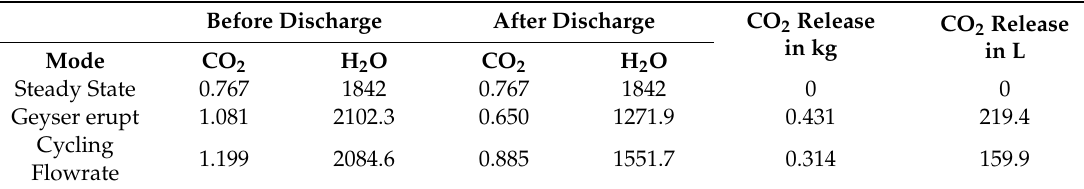
Table 4. Mass in place (kg) during the three Shaman